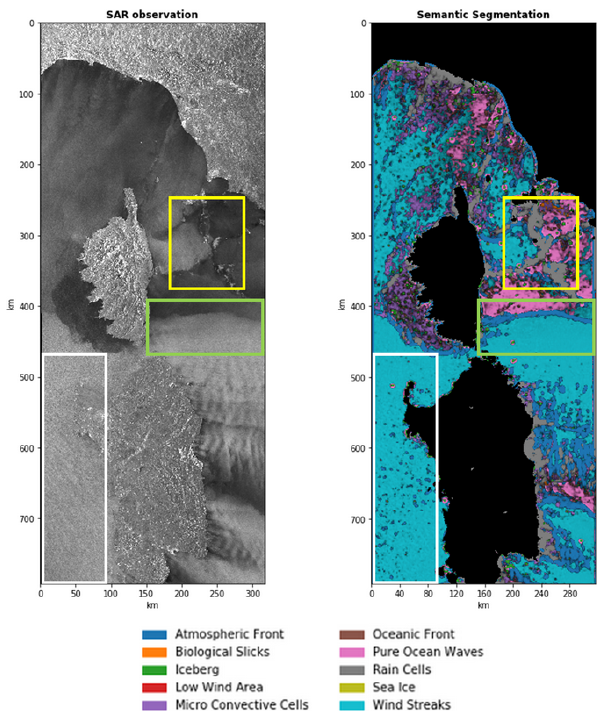
Figure 5. Interfermetric Wide-swath acquired the 20 November 2020 at 05:28 and its segmentation with the fully-supervised method. To account for geographical considerations, a model excluding the Sea Ice class is